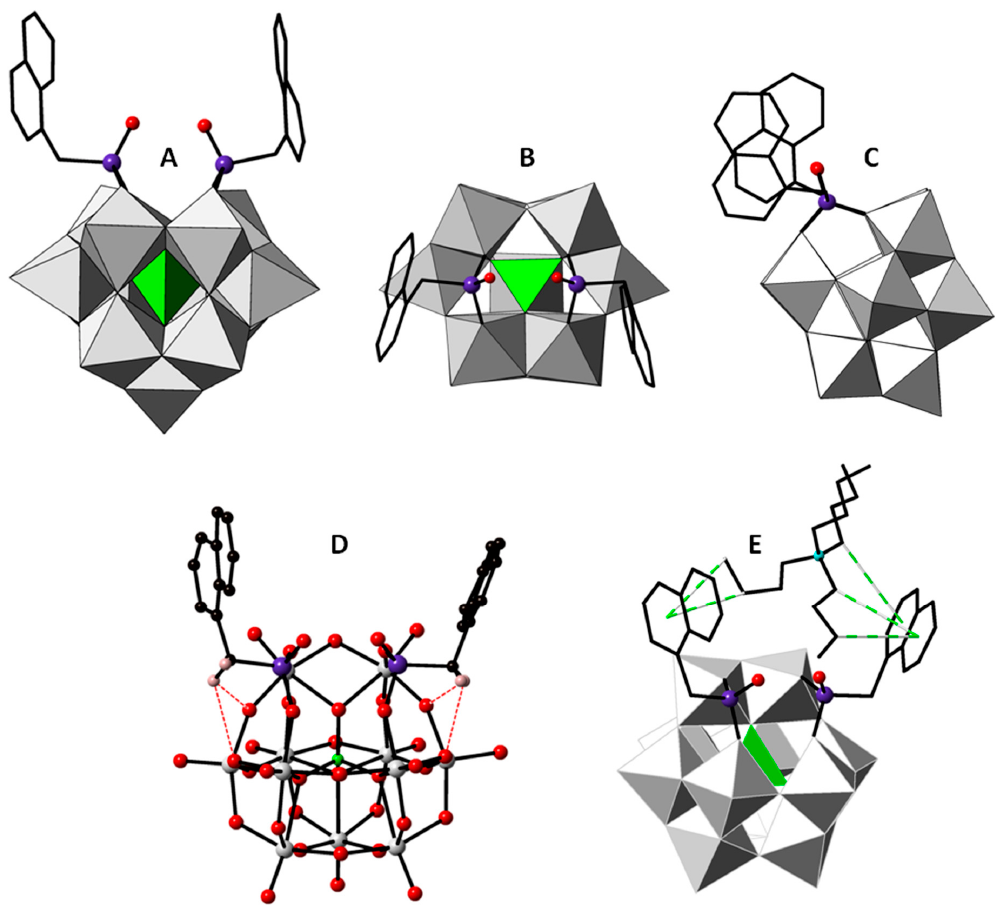
Figure 2. Polyhedral representation of the molecular structure of POMs 1 and 2 ( A ); The connectivity of the phosphonate groups and the relative arrangement of the naphthyl residues are highlighted in ( B ) and ( C ), respectively; Ball-and-stick representation of the hybrid POMs with intramolecular C–H···O POM hydrogen bonds depicted in red dashed lines ( D ); Detail of the TBA cation embraced between the two aromatic systems via C–H··· π interactions depicted as green dashed lines ( E ). Color code: WO 6 , gray octahedra (W, gray); XO 4 , green tetrahedra (X, green); P, violet; O, red; C, black; H, pink; N, cyan. Aromatic and n -butyl H atoms are omitted for clarity.